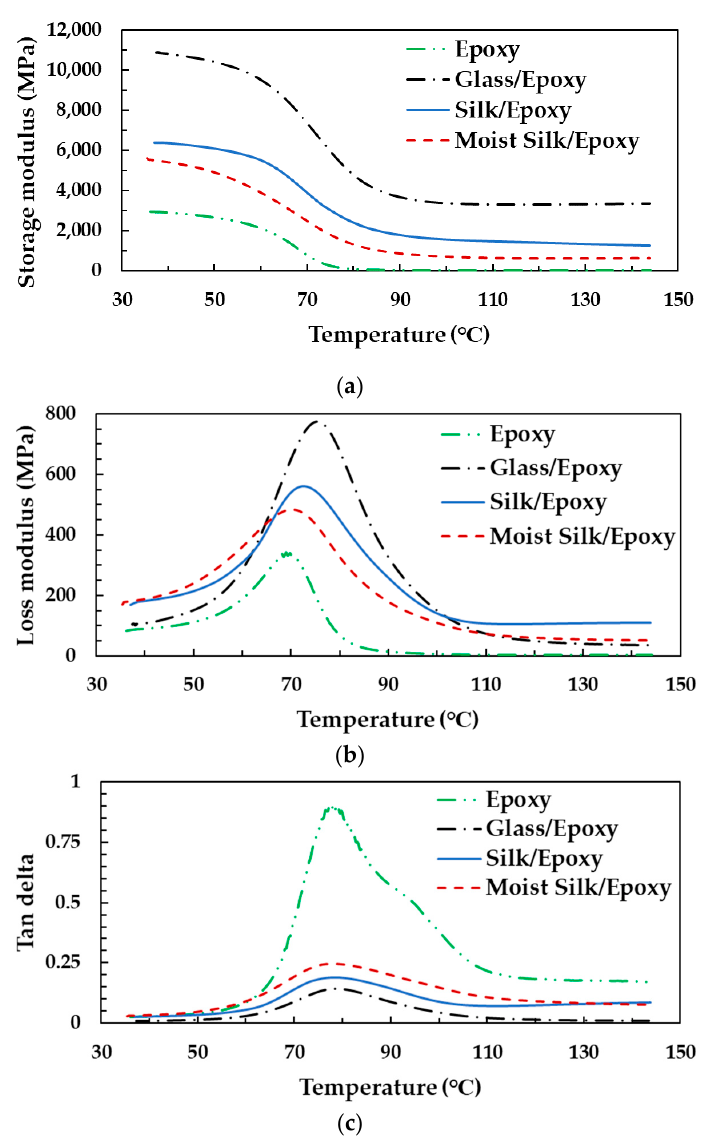
Figure 11. Representative changes of the ( a ) storage modulus E’, ( b ) loss modulus E”, and ( c ) tan δ for epoxy, glass/epoxy, and silk/epoxy laminates over a temperature range of 30 to 150 °C.